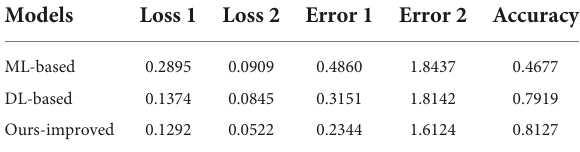
TABLE 4 Comparison of improved language communication ability evaluation results.